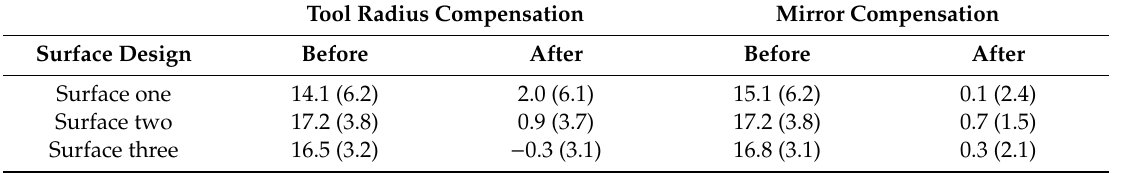
Table 3. Mean (the values without the parentheses) and the standard deviation (the values within the parentheses) of the errors for the three surfaces by using tool radius compensation or the mirror compensation, unit: μ m.